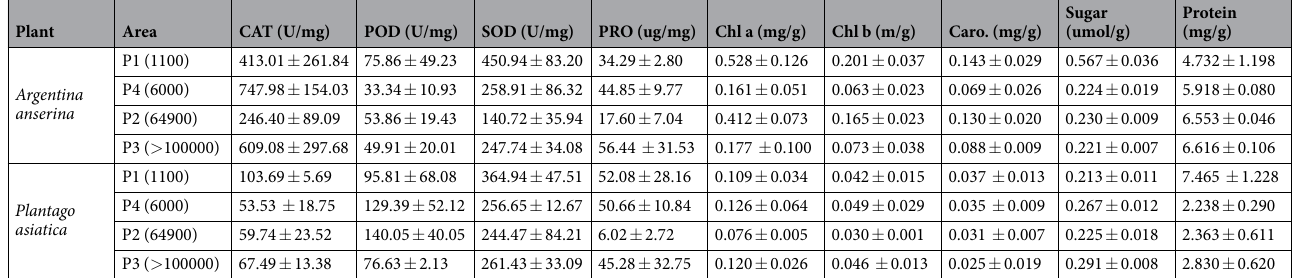
Table 2. Physiological and biochemical characteristics of plants under CO 2 incursion. Note: CAT: catalase; POD: peroxidase; SOD: superoxide; PRO: proline; Chl: chlorophyll; Caro: carotenoids; the number in the brackets under P1 to P3 is the measured CO 2 concentration (unit: ppm).